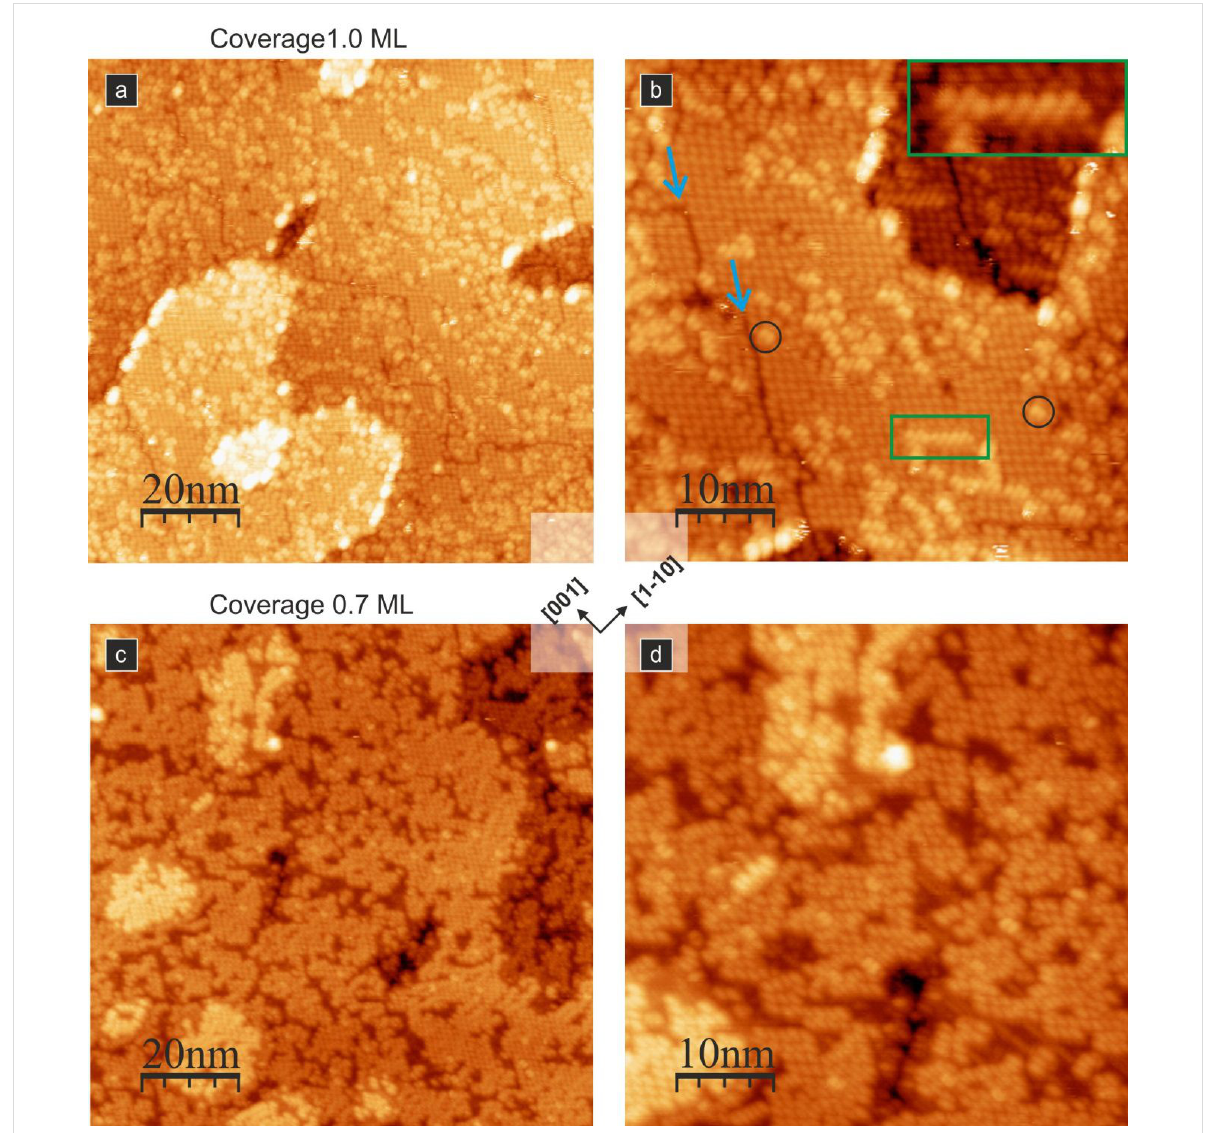
Figure 5: Empty-state STM images of the PTCDA molecules on the TiO 2 (110) surface after 100 °C annealing. (a) and (b): closed molecular layer (blue arrows mark domain boundaries, while black circles and a green rectangle mark admolecules on the top of the first layer); (c) and (d): 0.7 ML of PTCDA molecules. Well-ordered structures were obtained by the transformation of the meandering molecular lines shown in Figure 3 by thermal annealing; all images acquired with 2 pA tunnelling current and 2.0 V bias